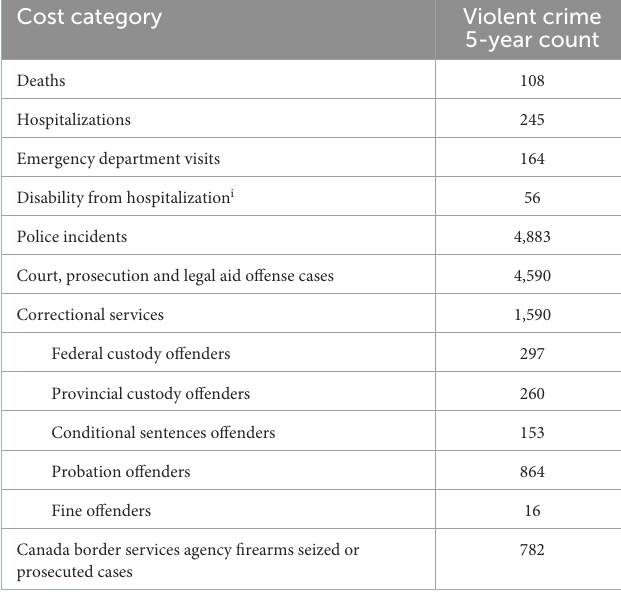
TABLE 3 Incidence of firearm violent crime deaths, injuries, offense cases, and offenders, B.C.